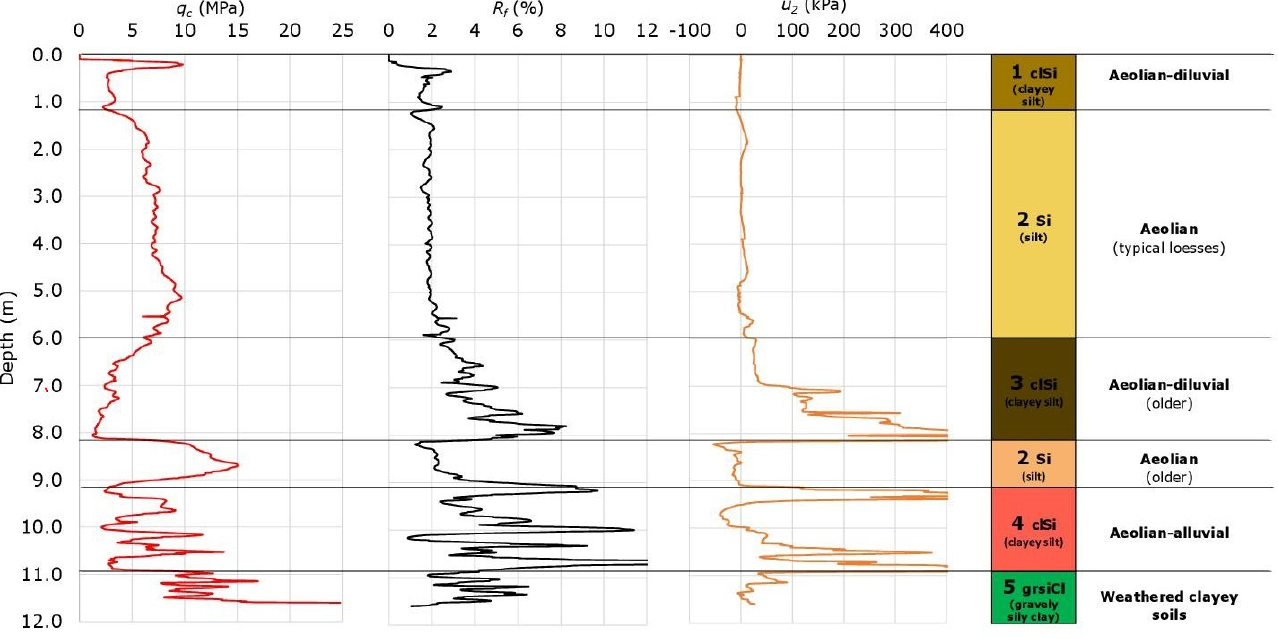
Figure 4. Representative CPTU profile from the Lublin.